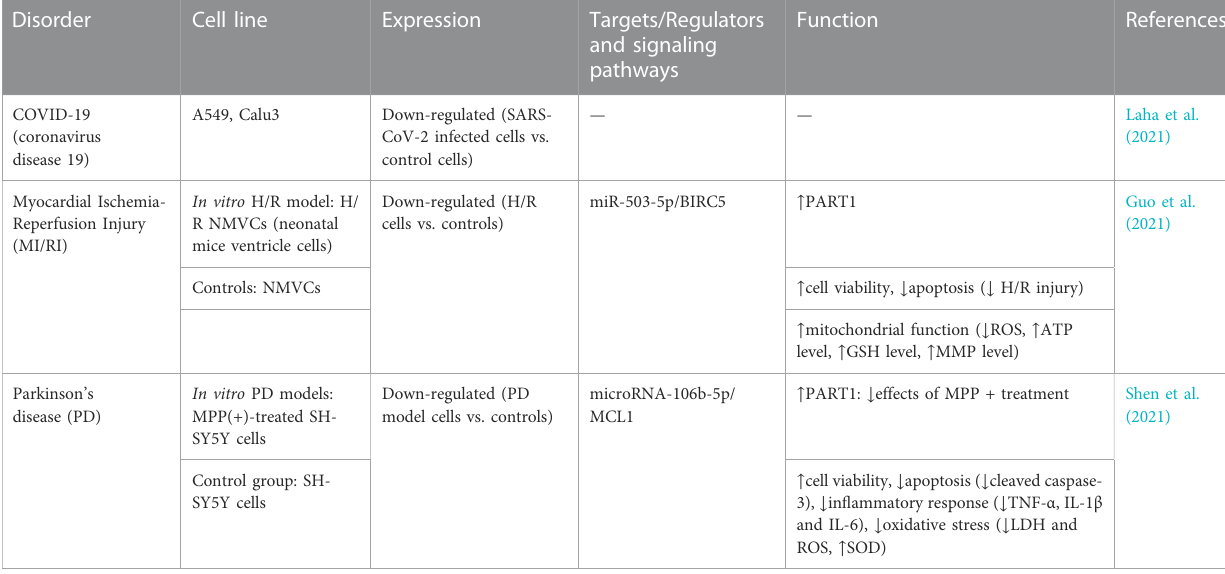
TABLE 8 Non-malignant illnesses in which PART1 has been down-regulated ( ↑ : increase, ↓ : decrease). Disorder